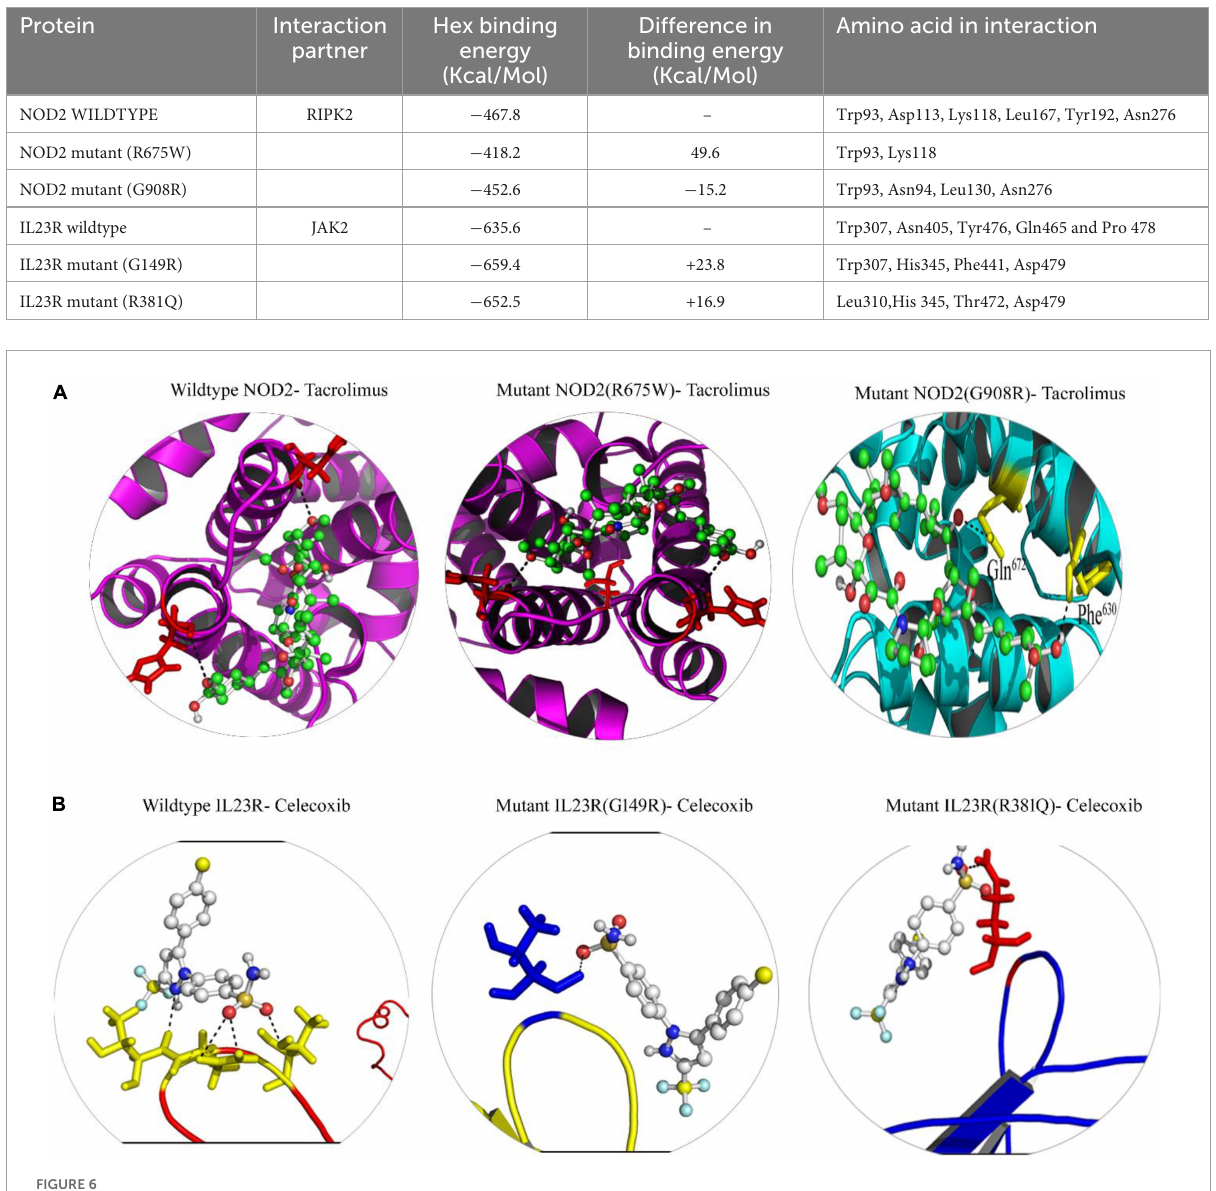
FIGURE6 (A) Molecular docking interaction of wild and mutant NOD2 with drug Tacrolimus. (B) Molecular docking interaction of wild and mutant Il23R with drug